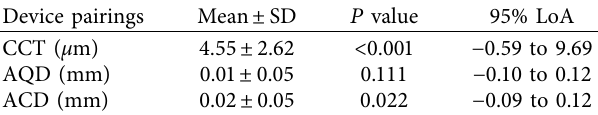
Table 2: The mean difference, paired t test ( P value), and 95% LoA for differences between the SS-OCT and TD-OCT devices.